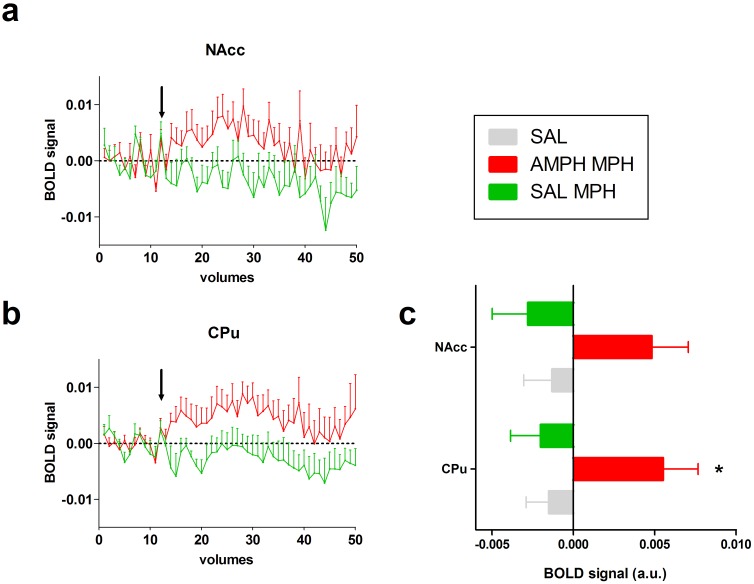
ROI analyses of phMRI data.phMRI time courses in the CPu (a) and NAcc (b). MPH or saline challenge was administered after 12 volumes (indicated by the arrow) followed by 38 volumes post-administration. The AMPH-MPH group differed significantly from the SAL-MPH and SAL groups. Difference between pre-injection (1–12) and post-injection (15–35) displayed for the CPU and Nacc (c) for each group (mean ±SEM)* p<0.05.